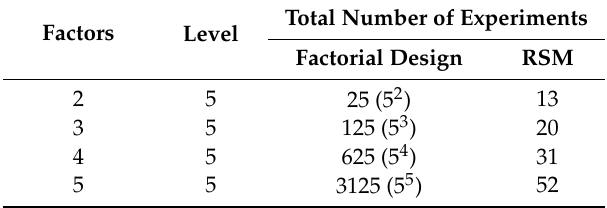
Table 1. Total number of experiments between factorial design and response surface methodology.